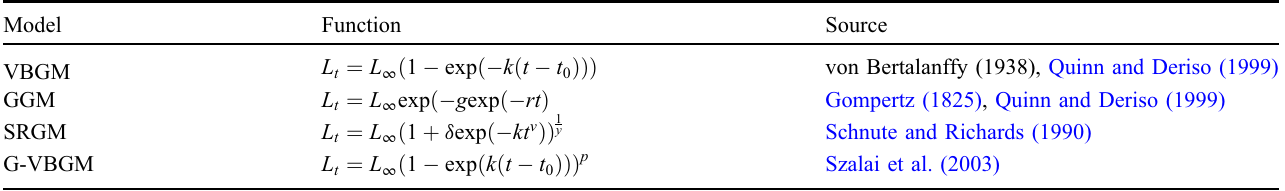
Table 2. Functions of the four growth models (VBGM, GGM, SRGM, G-VBGM) used in this study.